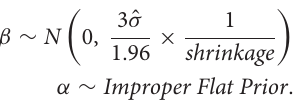
Frontiers in Ecology and Evolution |